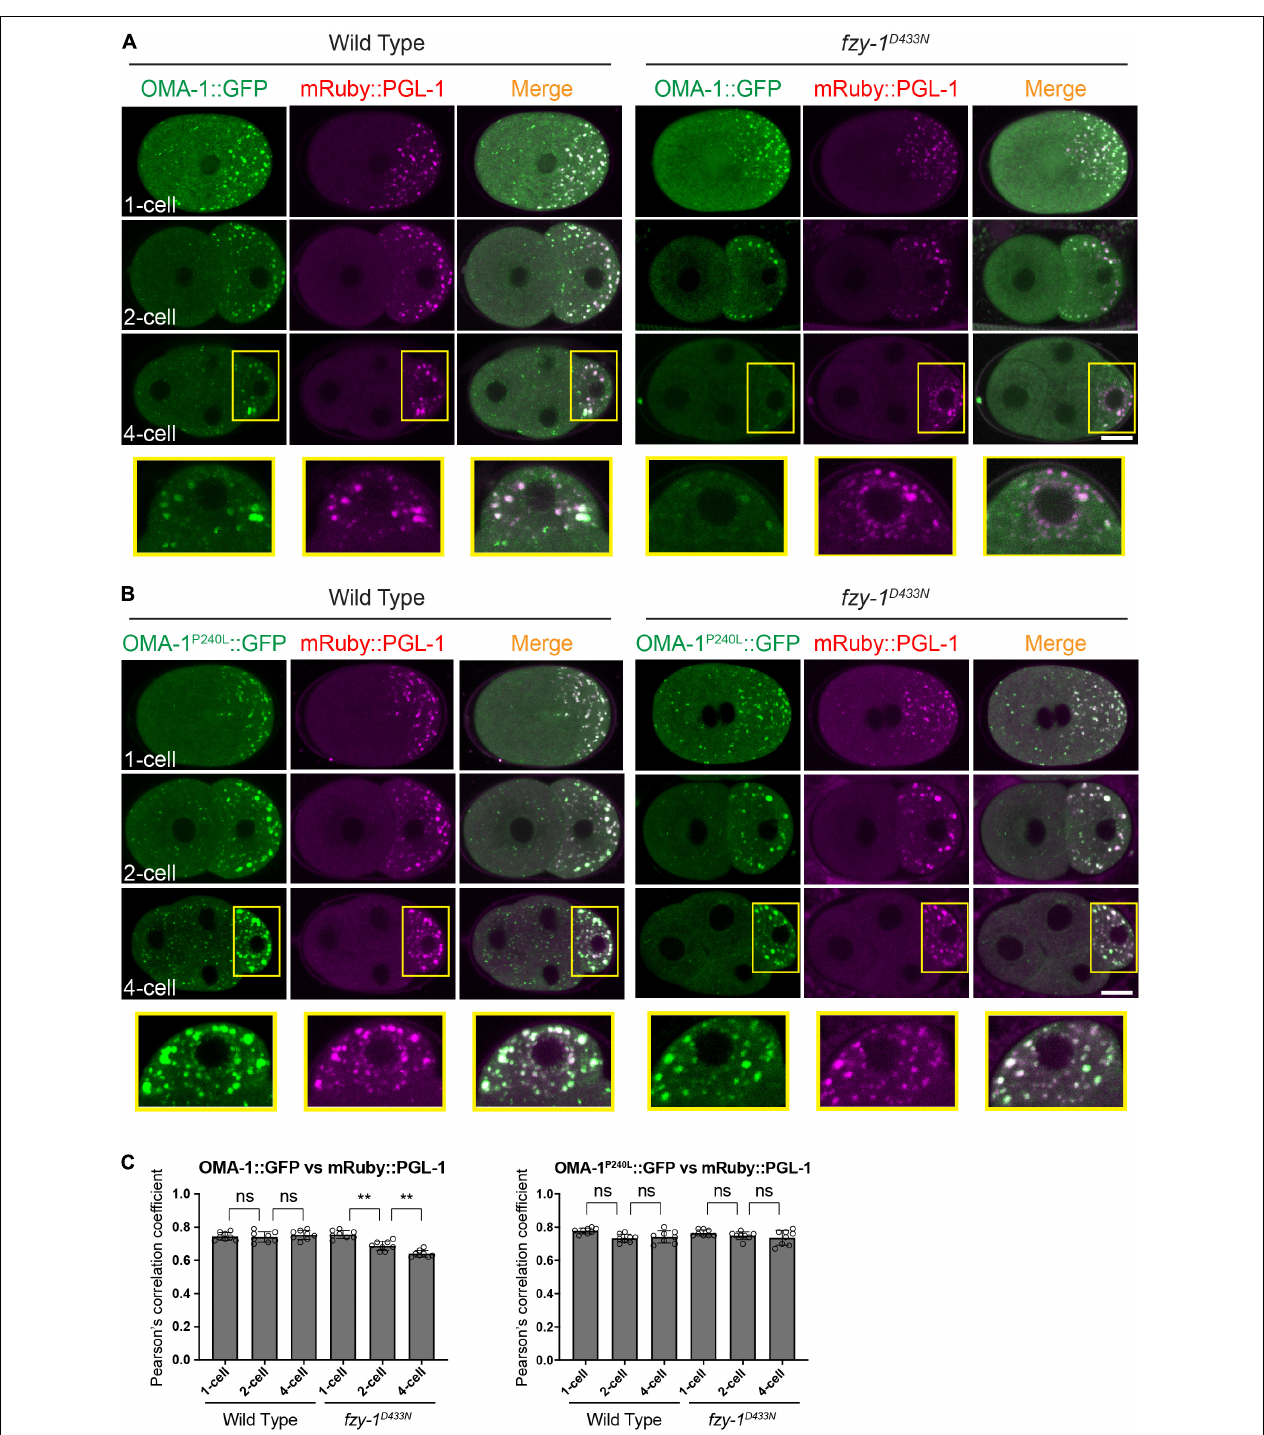
FIGURE 5 | OMA-1::GFP and OMA-1 P240L ::GFP are localized to P granules in early embryos. (A) Fluorescent micrographs show the co-localization of OMA-1::GFP and mRuby::PGL-1 in P granules in 1-cell, 2-cell, and 4-cell stage embryos in the wild type and fzy-1 D 433 N mutant. Regions within yellow rectangles are enlarged, turned 90 degrees counterclockwise, and displayed at the bottom. (B) Fluorescent micrographs show the co-localization of OMA-1 P 240 L :GFP and mRuby::PGL-1 in P granules in 1-cell, 2-cell, and 4-cell stage embryos in the wild type and fzy-1 D 433 N mutant. Regions within the yellow rectangles are enlarged, turned 90 degrees counterclockwise, and displayed at the bottom. Scale bar: 10 microns. (C) Pearson’s correlation coefficient to evaluate the extent of co-localization between OMA-1::GFP and mRuby::PGL-1. The results are presented as the average ± S.D. ** p < 0.01; ns: not significant. The p -values were calculated by 2-way ANOVA followed by Dunnett’s multiple comparisons. N =